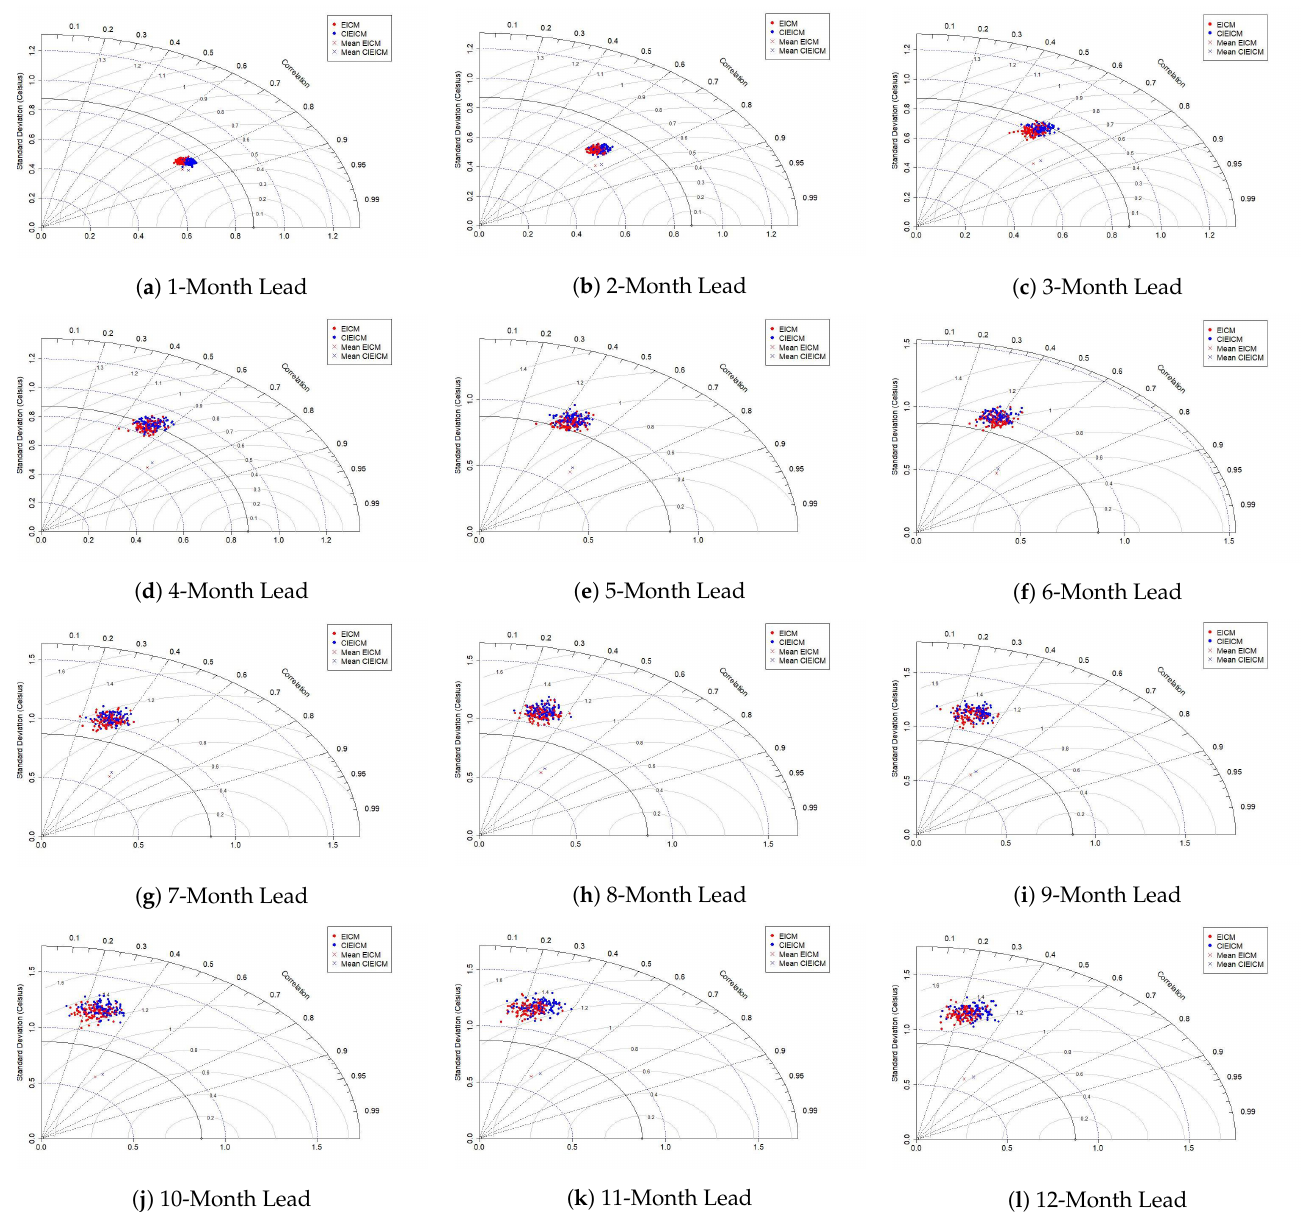
Figure 9. Taylor diagram comparing the SSTA index at Niño 3.4 (180 ◦ E–240 ◦ E and 5 ◦ S–5 ◦ N). Comparing the accuracy of the two simulations with HadISST for each month’s lead time from 1995 to 2019, the CIEICM was able to reduce the model error. With 1–8 months lead time, the CIEICM yielded better forecasts than the EICM. With 9–12 months lead time, the two simulations showed no significant differences in terms of RMSD , with the mean RMSD from CIEICM being approximately 0.017 less than EICM. When comparing the model relationships, it was found that the CIEICM was more correlated than the EICM, with an increase of approximately 0.11. In the ranges 1, 2–6, and 7–12 months lead, the relationship was at the levels of very strong, strong, and moderate, respectively, as shown in Table